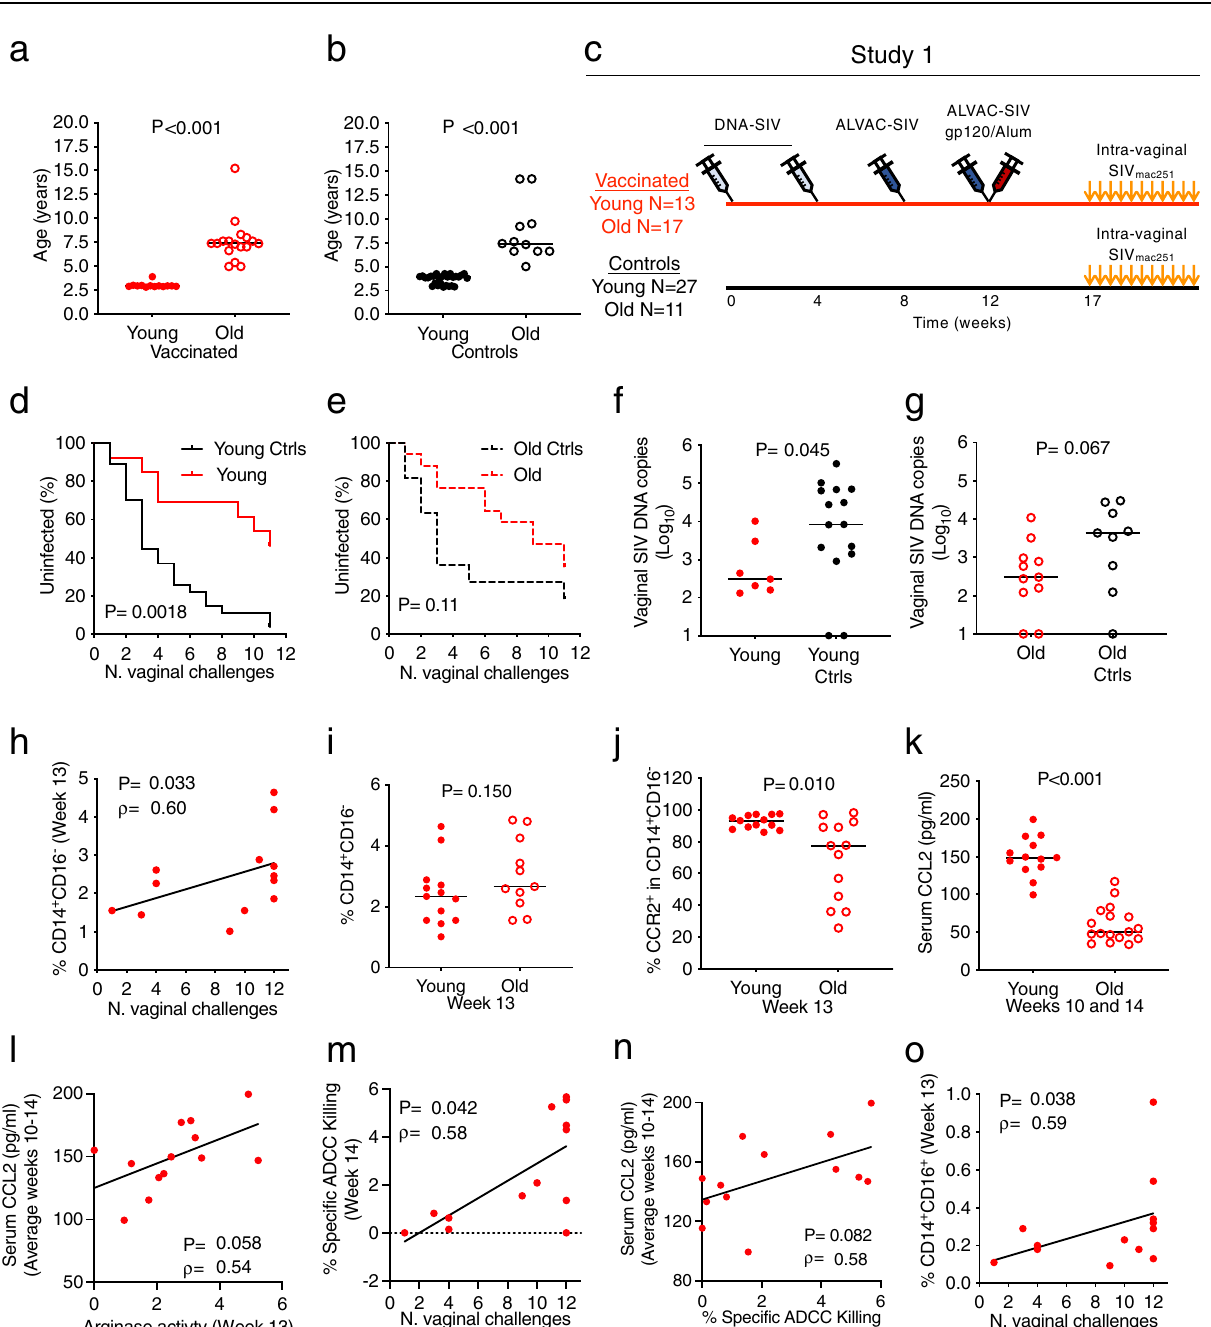
13). k Serum CCL2 levels (pg/ml) in n =13 young and n =17 old vaccinated animals (average weeks 10 and 14; p =0.0000001). l Correlation between the arginase activity measured in plasma at week 13 and the average of the serum CCL2 levels (pg/ml) at weeks 10 and 14 in n =13 young vaccinated animals. m , n Correlations between( m )theaverageofadjustedspeci fi cADCCkillingofSIV mac251 -infectedcells atweek14assessedatdifferentplasmadilutionsandtheTOA,or( n )theaverageof the serum CCL2 levels (pg/ml) at weeks 10 and 14 in n =13 young vaccinated ani- mals. o Correlation between the frequency of intermediate monocytes (CD14 + CD16 + HLA-DR + in live cells) at week 13 and the TOA in n =13 young animals. Comparisons: a , b , f , g , i – k Two-tailed Mann – Whitney t -test with median. Corre- lation analyses: h , l – o two-tailed Spearman correlation test and simple linear regression. Displayed p values are unadjusted. Source data are provided in the Source Data fi